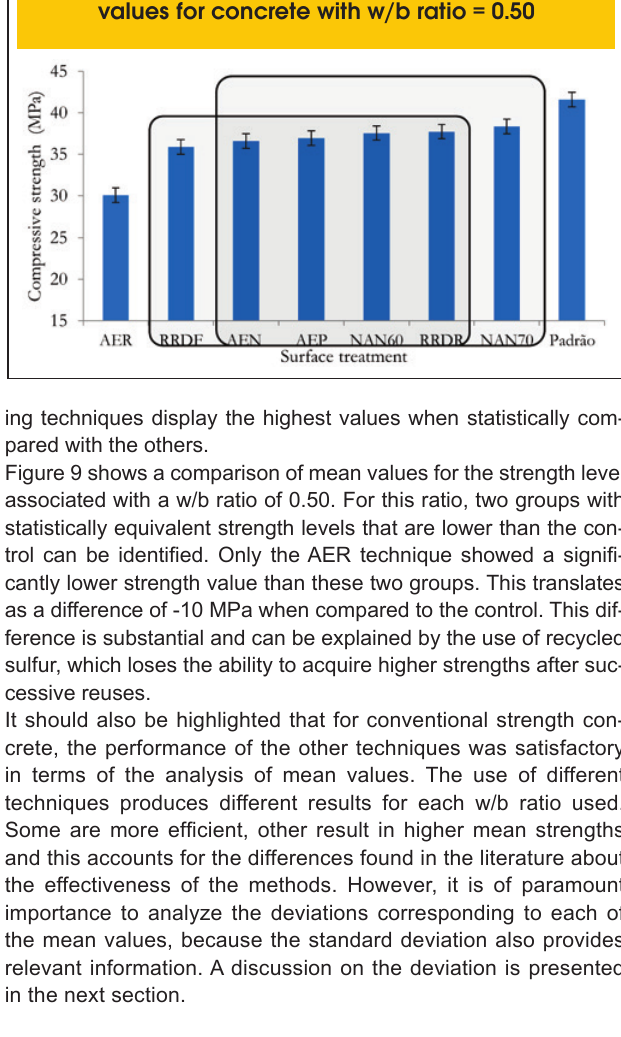
Figure 9 – Comparison of the mean values for concrete with w/b ratio = 0.50